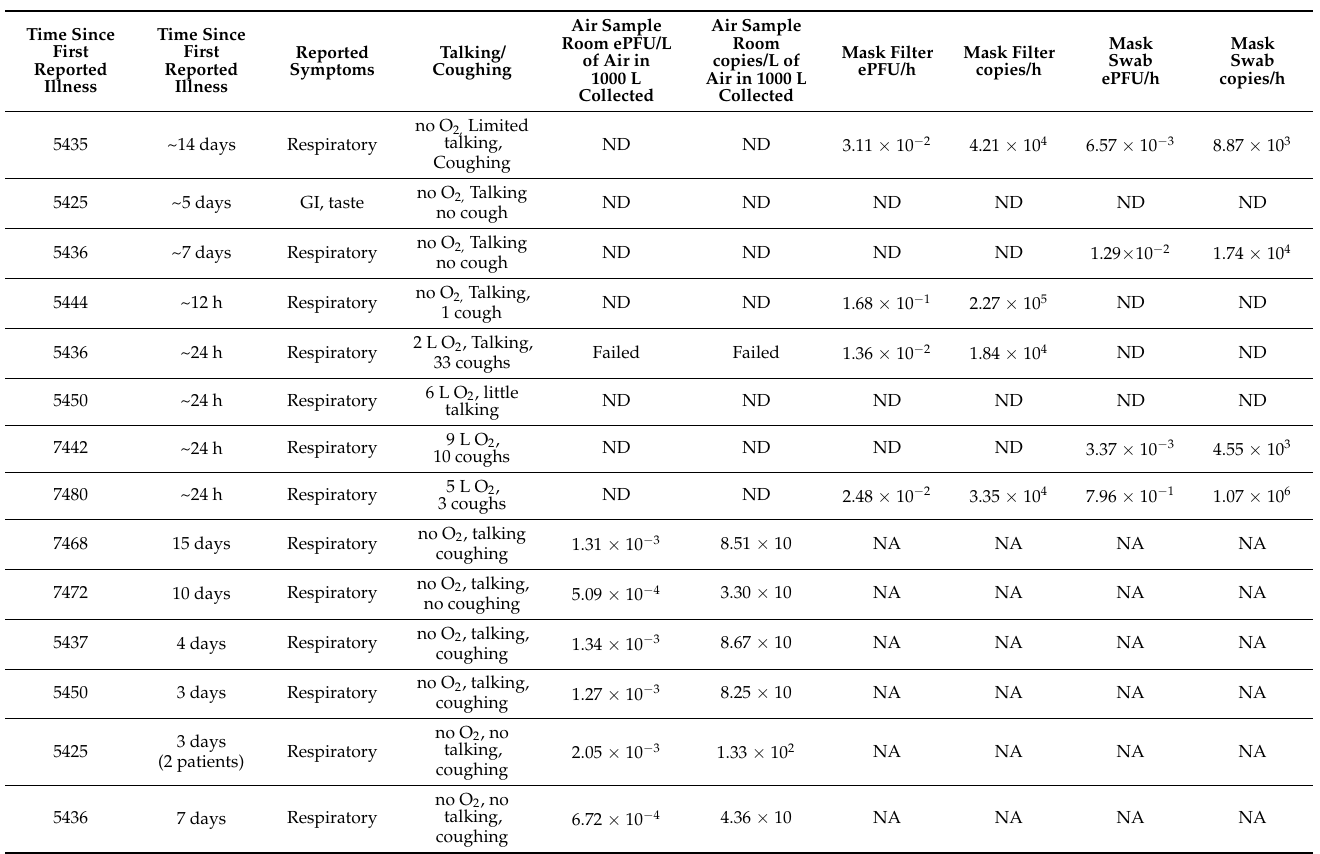
Table 4. Results of samples collected around hospitalized patients. The first 8 patients listed wore the device during collection, while the last 6 did not wear the device. ND indicates that target RNA was not detected. NA indicates that the experiment was not performed. “Failed” was used to indicate an experiment that was carried out, but where the sampler failed to operate correctly during the